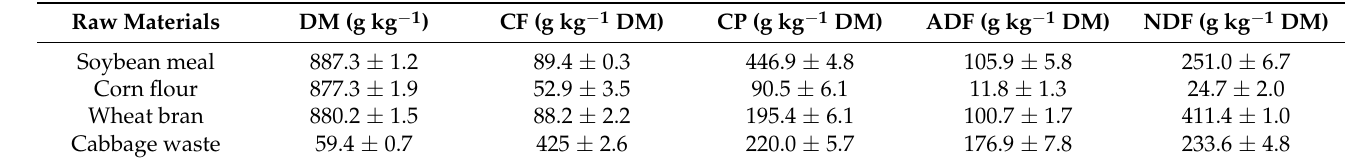
Table 1. Ingredient list of raw materials.